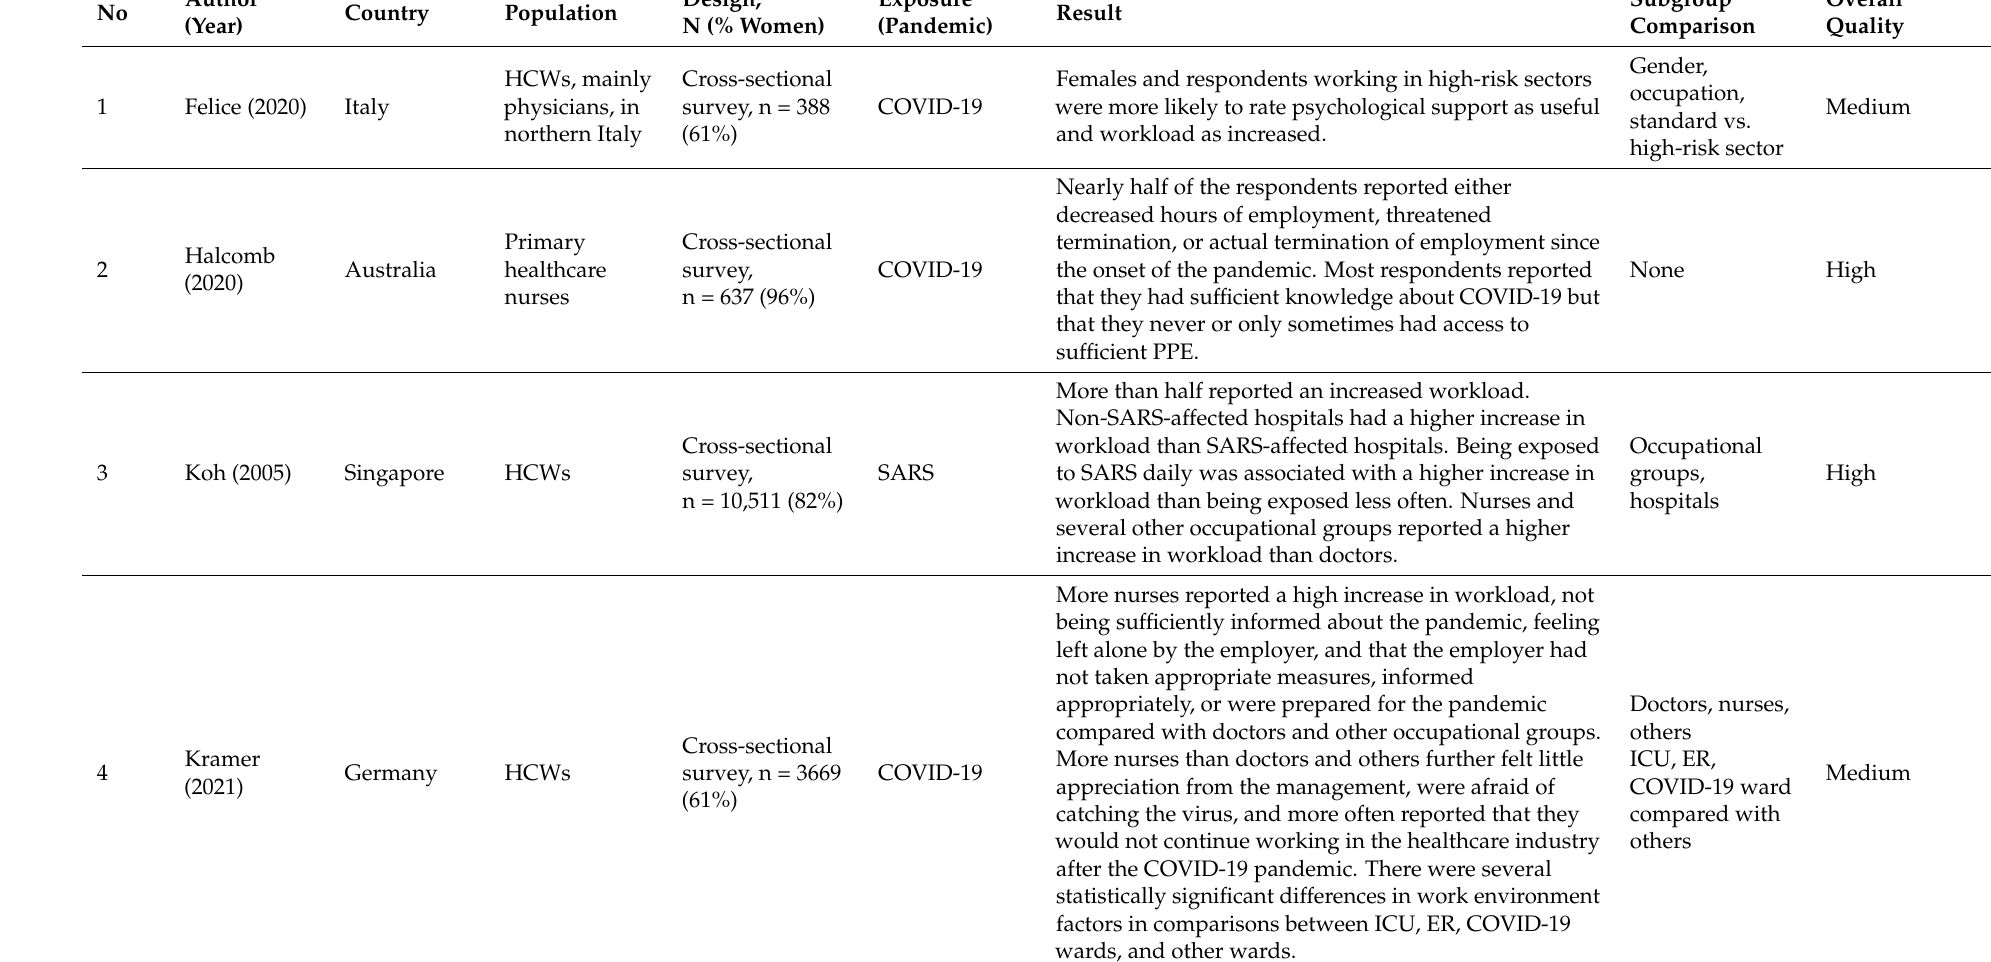
Table 1. Overview of quantitative studies assessing how the work environment is affected by an epidemic or pandemic (COVID-19, SARS, or MERS) in the healthcare industry (research question